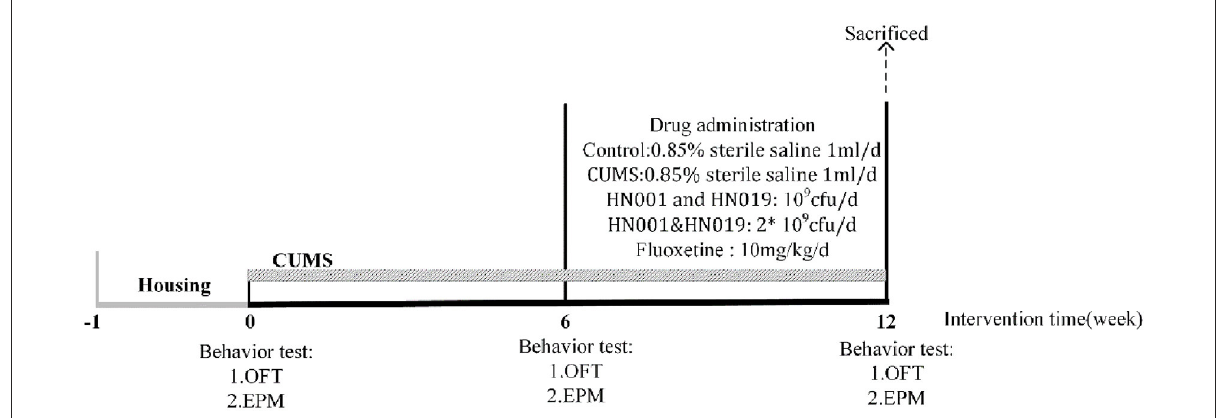
FIGURE1 The entire experiment producer. CUMS chronic unpredictable mild stress, OFT open-field test, EPM elevated-plus